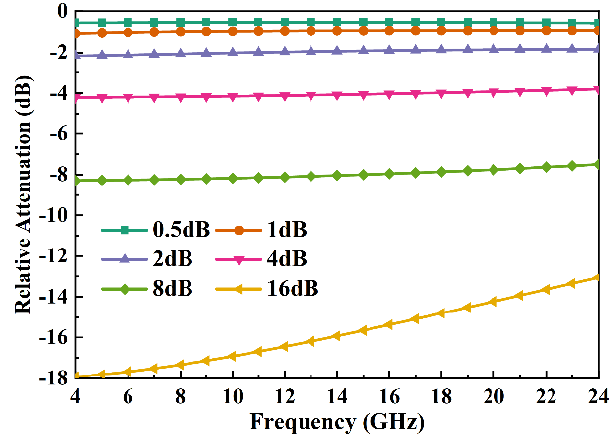
After replacing R 1 and R 2 in (3) and (4) with the values in (1) and (2), it can be found that the IL of the T-type attenuation cell will increase significantly and the amplitude stability will deteriorate when the T-type network is applied to a large attenuation level, as shown in Figure 3. Therefore, the T-type structure is not suitable for large attenuation levels and is used only for 0.5 dB attenuation and 1 dB attenuation in most situations.